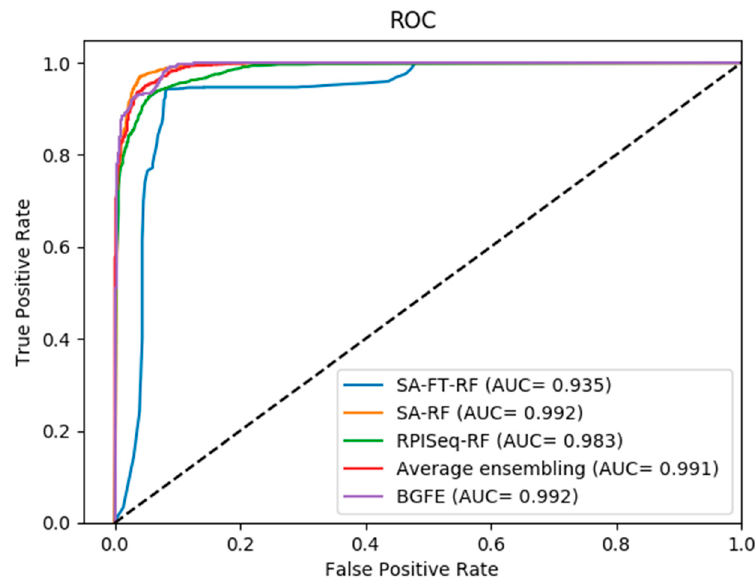
Figure 3. ROC curves of performance comparisons between BGFE and other strategies on dataset RPI1807.